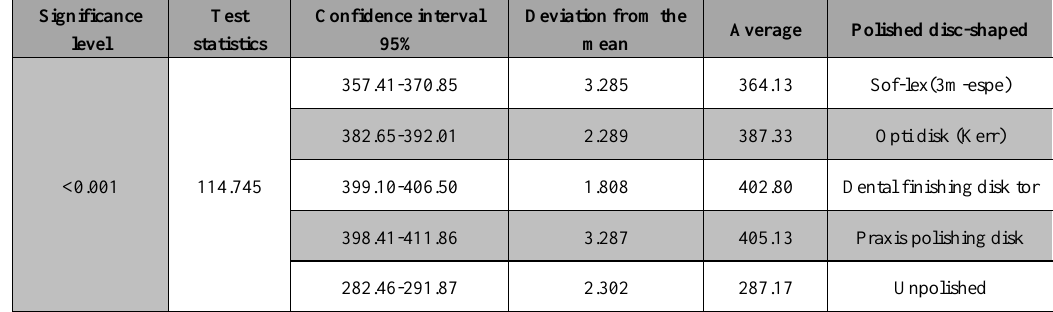
Polished disc-shaped Average